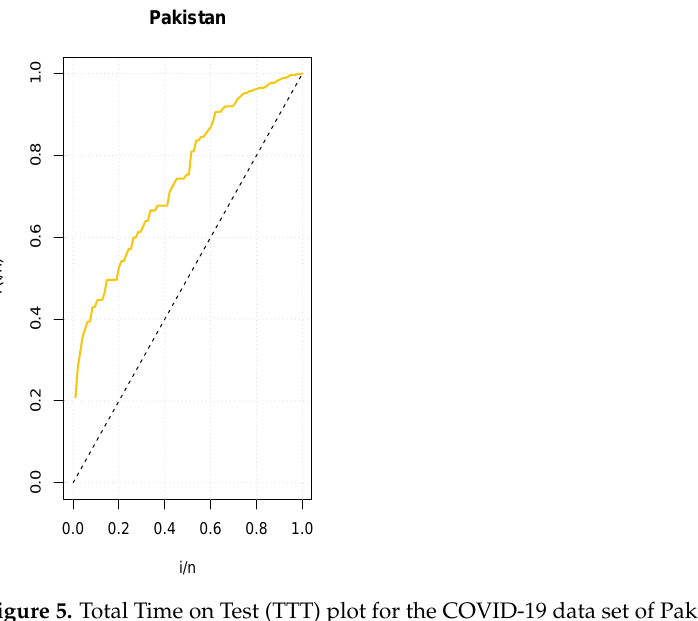
Figure 5. Total Time on Test (TTT) plot for the COVID-19 data set of Pakistan.